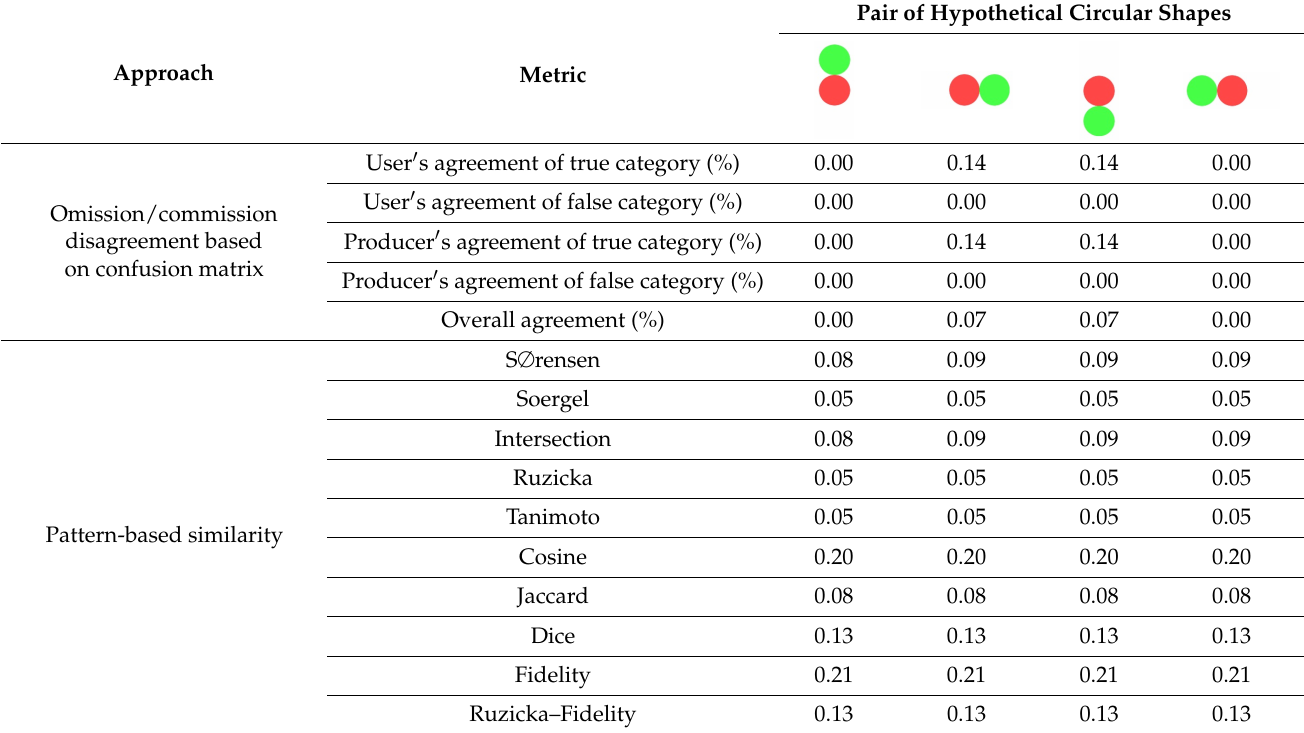
Table A3. Comparison between omission/commission disagreement approach and pattern-similarity-based approach to measure pairs of a hypothetical circular shape and their displacements in cardinal directions that touch at the perimeter.